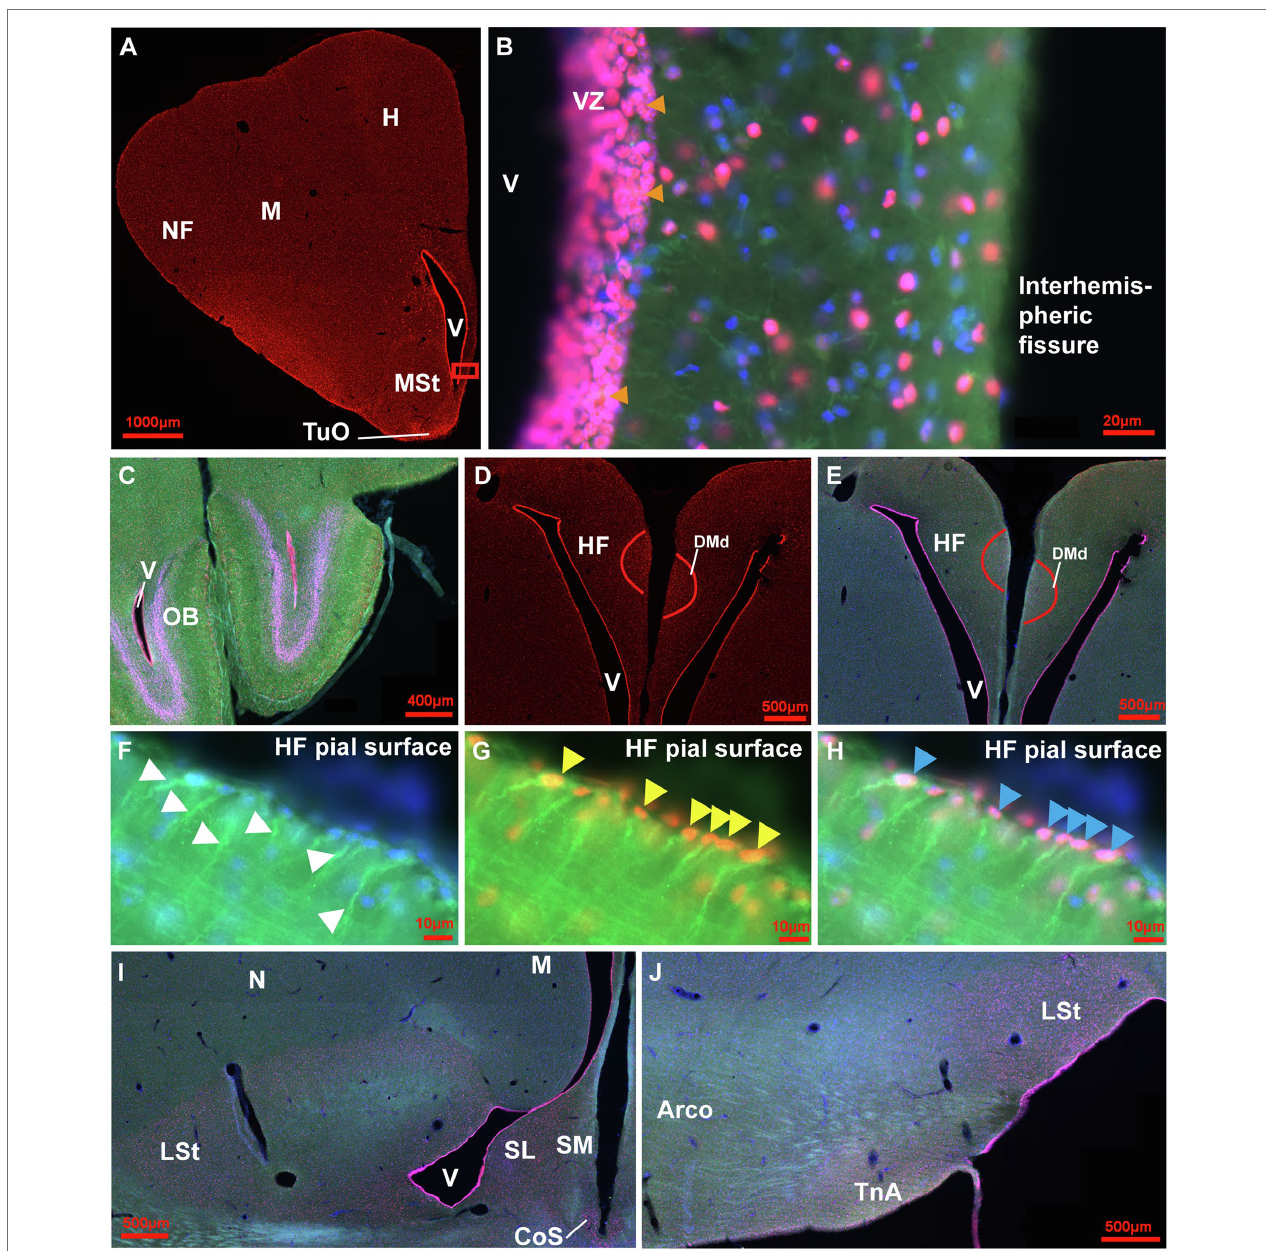
FIGURE 3 | Distribution of Sox2+ cells in the adult pigeon forebrain. (A) Sox2 expression (red) in a frontal section at atlas level A13.00 (Karten and Hodos, 1967). Intense labelling can be observed in the ventricular zones, at the pial surface and in TuO. (B) Magnification of the ventricular zone (box in A) with triple-staining of Sox2 (red), GFAP (green) and Hoechst (blue). Pinkish cells show double labelling for Sox2 and Hoechst indicating nuclear expression in cells of stage 1 and 2. Yellow/Orange cells show triple labelling for Sox2, GFAP and Hoechst. In addition, green GFAP-positive radial fibres from the ventricular zone can be seen. Orange arrowheads point to cell clusters of stage 2. (C) Triple staining in the OB at atlas level A14.50 showing intense labelling in the ventricular zone and in the internal granular layer. (D) Sox2 expression in the HF with intense labelling of cells in DMd and the ventricular zone at atlas level A7.75. (E) Triple-labelling in the HF shown in (D) . (F-H) Magnifications of the pial surface of the HF at atlas level A7.00. GFAP+ (green)/Hoechst+(blue) radial cells with radial fibres (white arrowheads) shown in F. GFAP+/Sox2+ (yellow) radial cells (yellow arrowheads) shown in G . GFAP+/Sox2+/Hoechst+ (pink/orange) radial cells (blue arrowheads) shown in H . (I,J) Triple- staining of Sox2 (red), GFAP (green) and Hoechst (blue) of frontal sections at atlas level A7.75 (I) and A6.25 (J) that show enhanced positive signals in the LSt, the ventricular zone, SL, SM, CoS and TnA in comparison to less signals in N, M and Arco. For abbreviations see